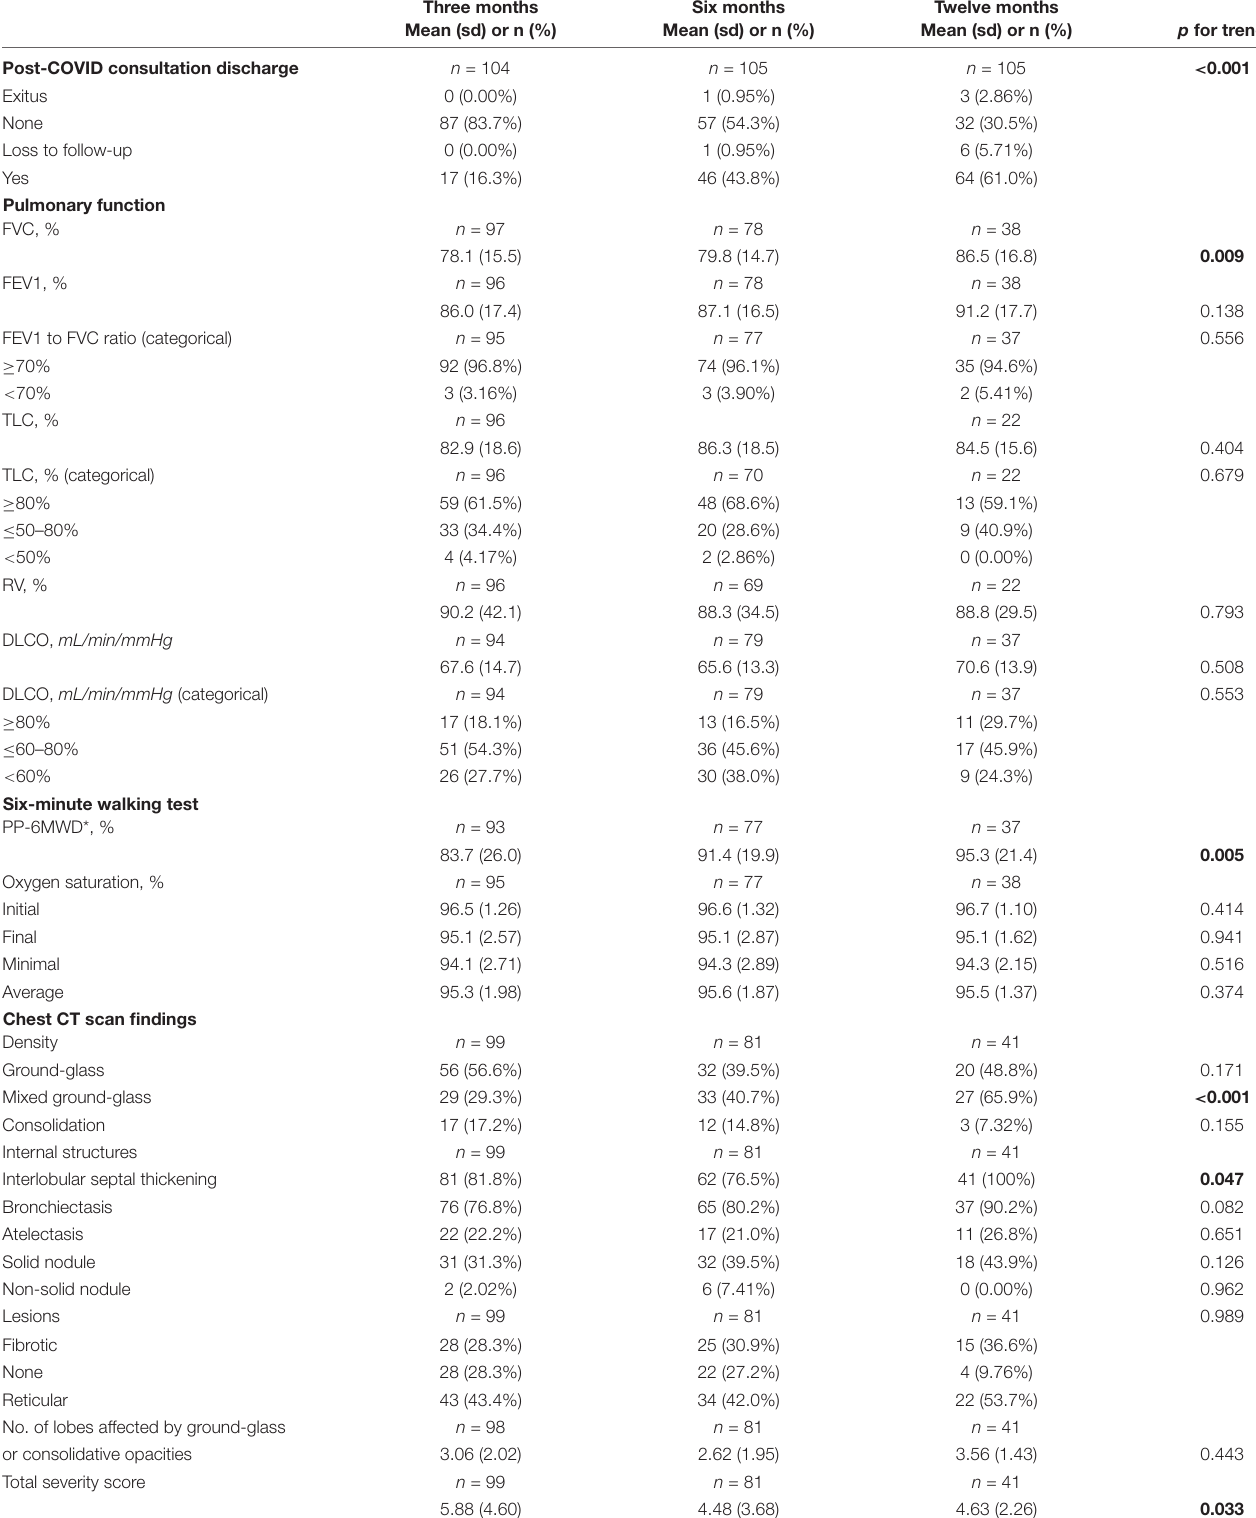
TABLE 2 | Description of pulmonary function, 6MWT, and chest CT findings of patients followed at 3, 6, and 12 months. Three months Six months Twelve months Mean (sd) or n (%) Mean (sd) or n (%) Mean (sd) or n